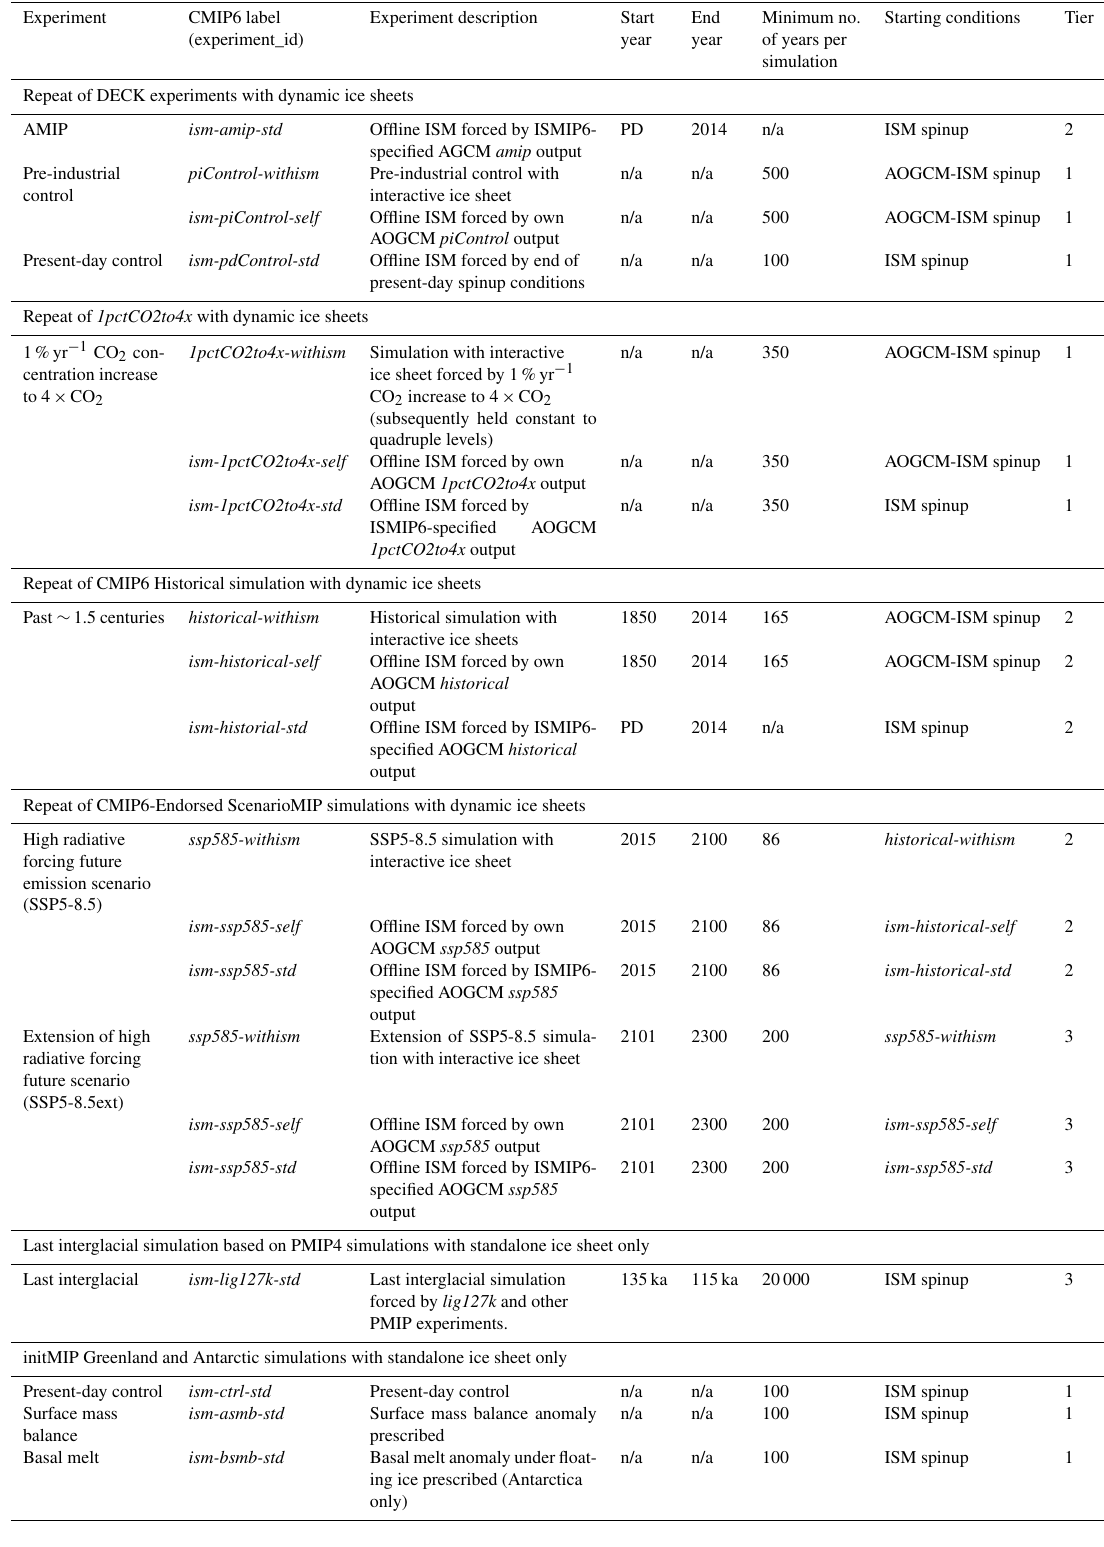
Table 2. Overview of the ISMIP6 experiments with dynamic ice sheets that are either coupled to climate models (AOGCM-ISM, XXX- withism ) or run offline (ISM, ism-XXX-self , and ism-XXX-std ). All experiments are started on 1 January and end on 31 December of the specified years. PD indicates that the start date corresponds to the date of the present-day ISM spinup. n/a stands for not